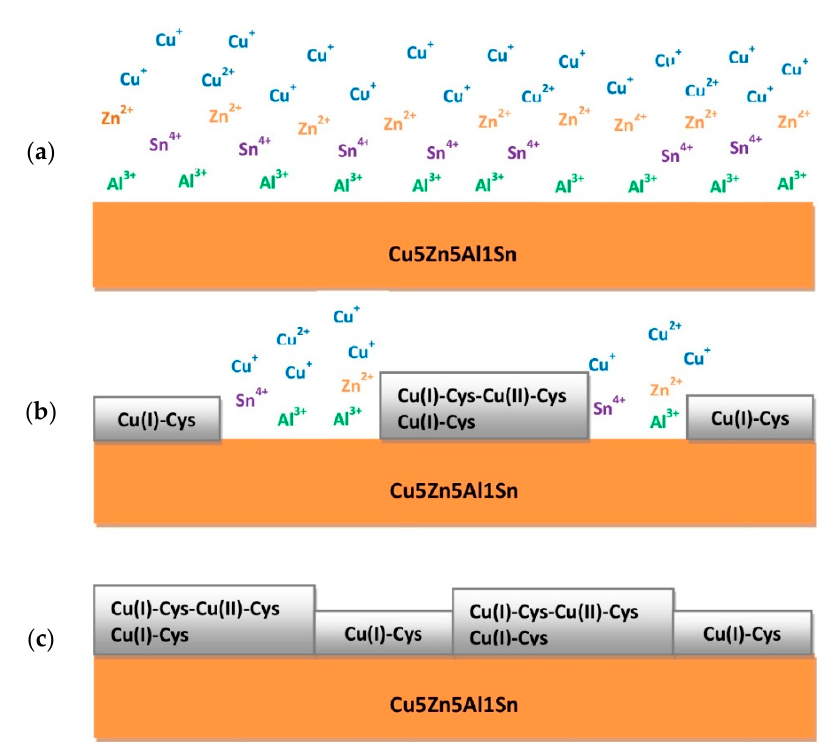
Figure 9. Schematic representation of the corrosion mechanism of the Cu5Zn5Al1Sn alloy in 3.5 wt.% NaCl solution before ( a ) and after addition of 10 − 4 M ( b ) and 10 − 2 M ( c )